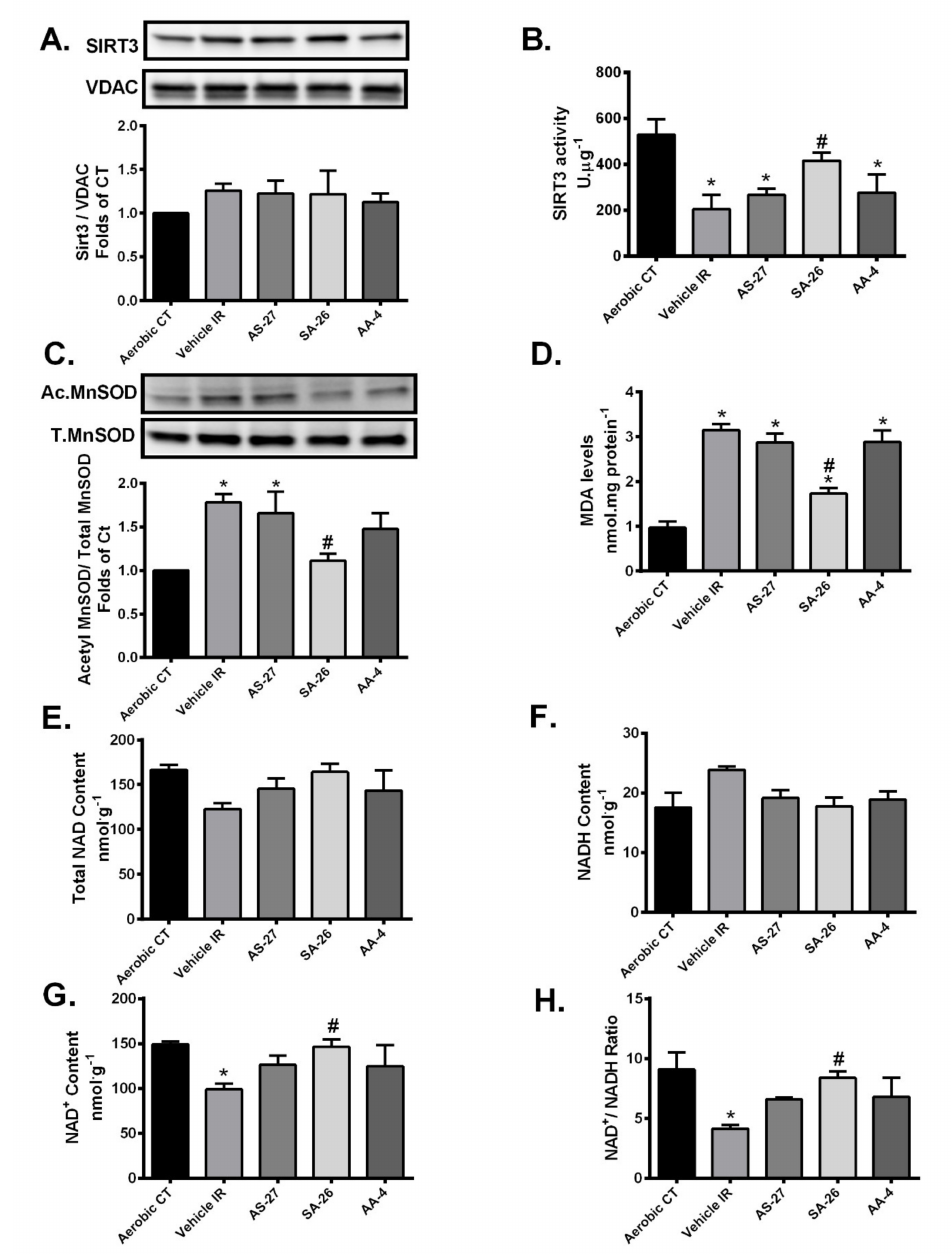
Figure 3. Preservation of NAD + / NADH control ratio and SIRT3 activity limited oxidative stress following IR injury. ( A ) Representative immunoblots and densiometric quantification of the expression of mitochondrial protein SIRT3 in mice hearts after 30 min ischemia and 40 min reperfusion. Protein expression was normalized to voltage-dependent anion channel (VDAC) protein used as a loading control. ( B ) Cardiac SIRT3 activity was determined in mitochondrial fractions in mice hearts after 30 min ischemia and 40 min reperfusion using a SIRT3 fluorescent assay kit. ( C ) Representative immunoblots and densiometric quantification of the relative protein expression of AcMnSOD normalized to total manganese superoxide dismutase (MnSOD) in mice hearts after 30 min ischemia and 40 min reperfusion. ( D ) Cardiac malondialdehyde (MDA) levels assessed using a lipid peroxidation (MDA) colorimetric assay kit in mice hearts following 30 min ischemia and 40 min reperfusion. Cardiac levels of ( E ) Total NAD, ( F ) NADH, ( G ) NAD + and ( H ) NAD + / NADH ratio expressed as nmol per g dry weight assessed in mice hearts after 30 min ischemia and 40 min reperfusion. Values represent mean ± SEM, * p < 0.05 vs. Aerobic CT (control), # p < 0.05 vs. Vehicle IR ( n = 4–5 per